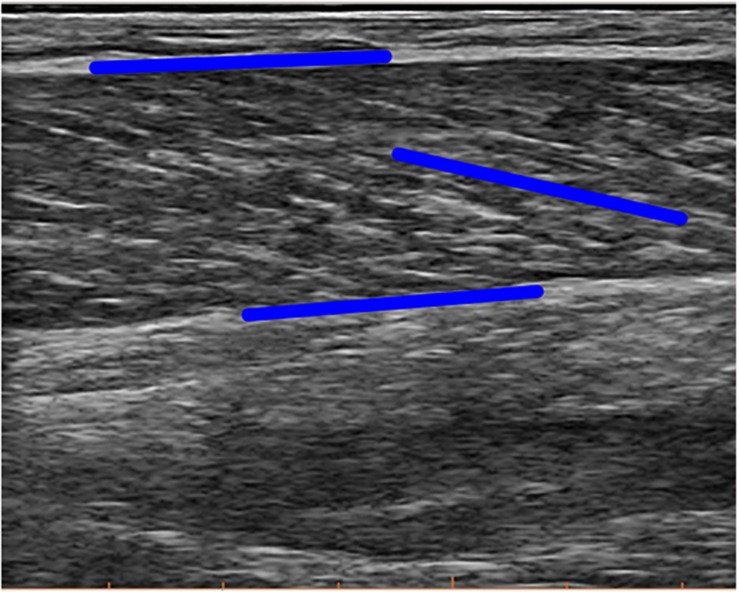
Example image of the ultrasound measurement. Blue lines illustrate tracking of the orientation of both aponeuroses and the fascicle. Note that the blue line in parallel to the fascicle here is not the final fascicle length, rather extrapolation methods were used on the local coordinates of these lines to calculate final fascicle length and pennation angle.